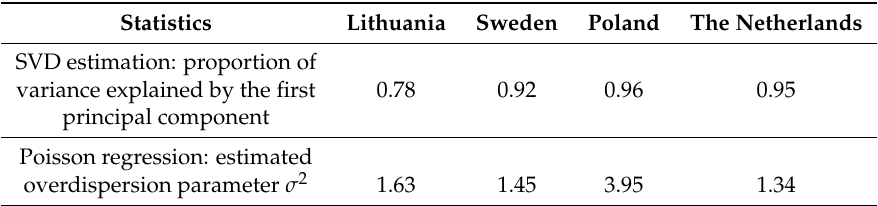
Proportion of variance explained by the first principal component and estimated overdispersion parameter for fitted Lee-Carter model. Overdispersion was estimated as the sum of squared Pearson residuals divided by the residual degrees of freedom.